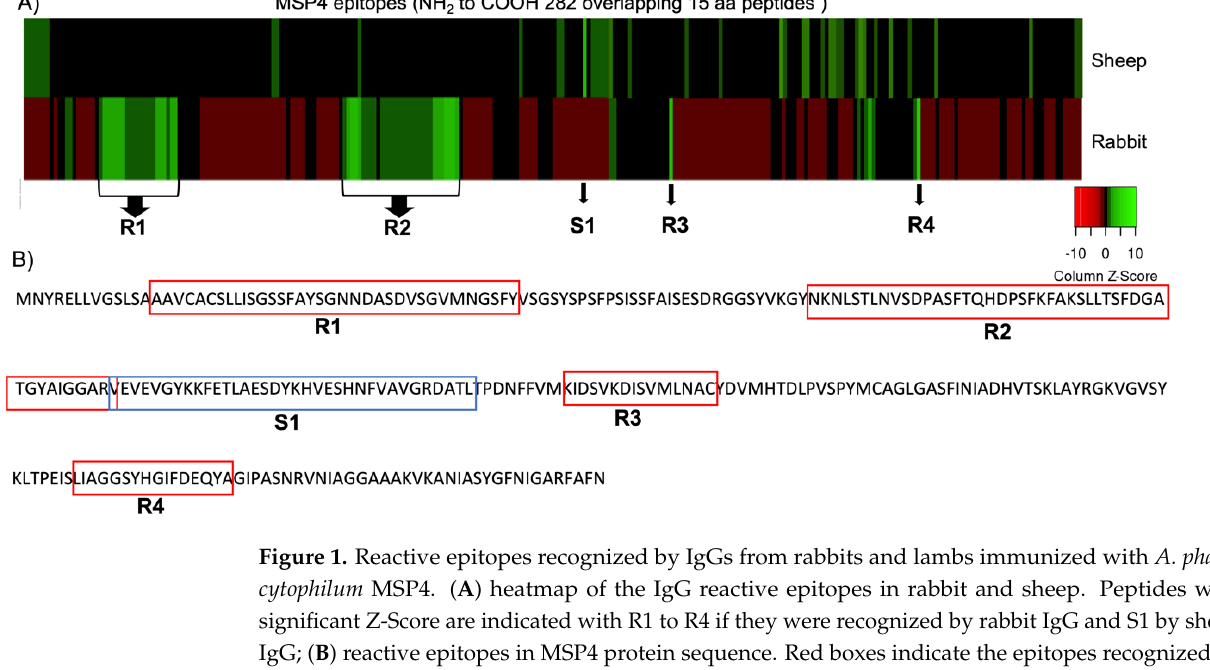
Table 1. A. phagocytophilum MSP4 (GenBank ID: AFD54597) predicted immunogenic peptides reac- tive to IgGs from rabbit and sheep immunized with the recombinant protein.